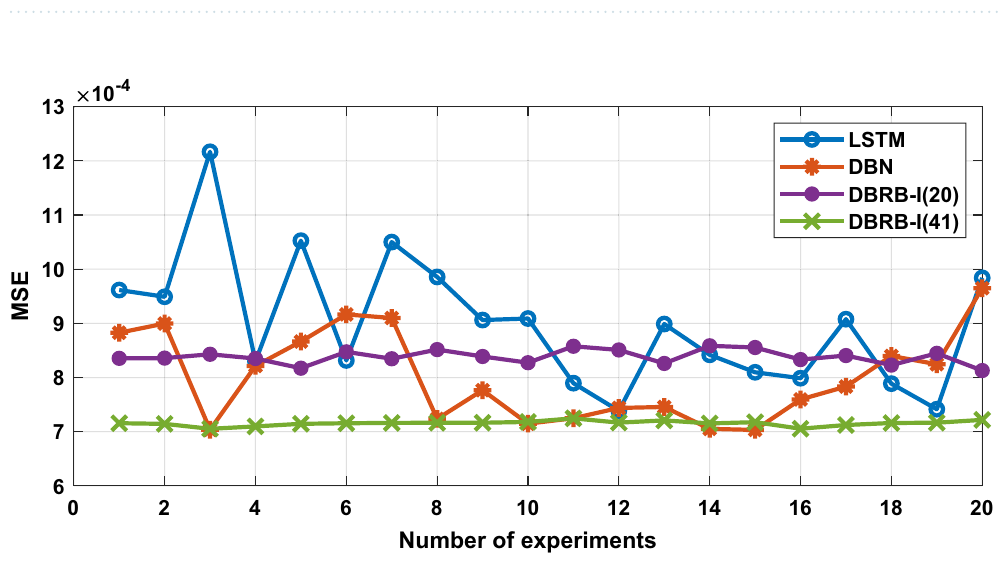
Figure 26. Compare predictions from different